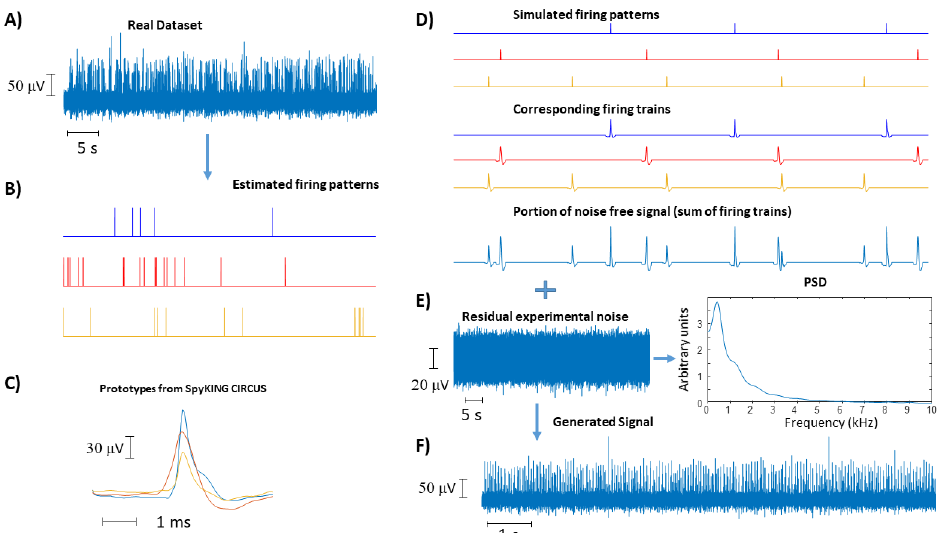
Figure 2. Simulation of data. ( A ) Portion of experimental data considered to extract prototypes of neuron spikes. ( B ) Example of spikes identified by SpyKING Circus, separated after sorting. ( C ) Prototypes identified. ( D ) Simulation of a portion of data by generating the firing patterns corresponding to each prototype, the firing trains (by convolution) and the overall signal (sum of firing trains). ( E ) Model of noise: The experimental noise is obtained by subtracting the identified spikes from the experimental data and its power spectral density (PSD) is estimated (by Burg method of order 20). ( F ) Final simulation of noisy data by summing the noise-free signal ( D ) and colored Gaussian noise with the same PSD as the experimental one ( E